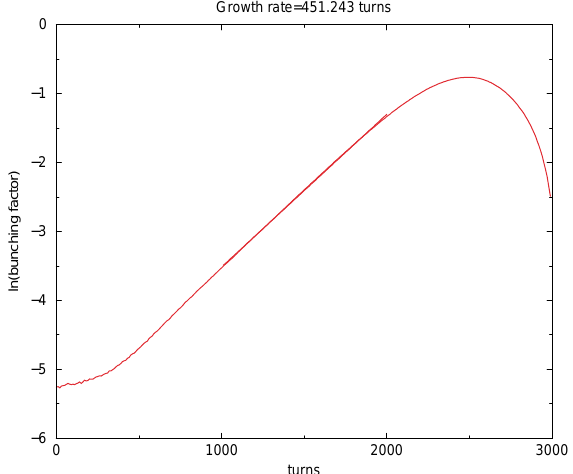
FIG. 2. (Color) The logarithm of the bunching factor as a func- tion of the turn number. A linear least squares fit to the slope in a finite region yields the growth rate of the mode that is unstable.